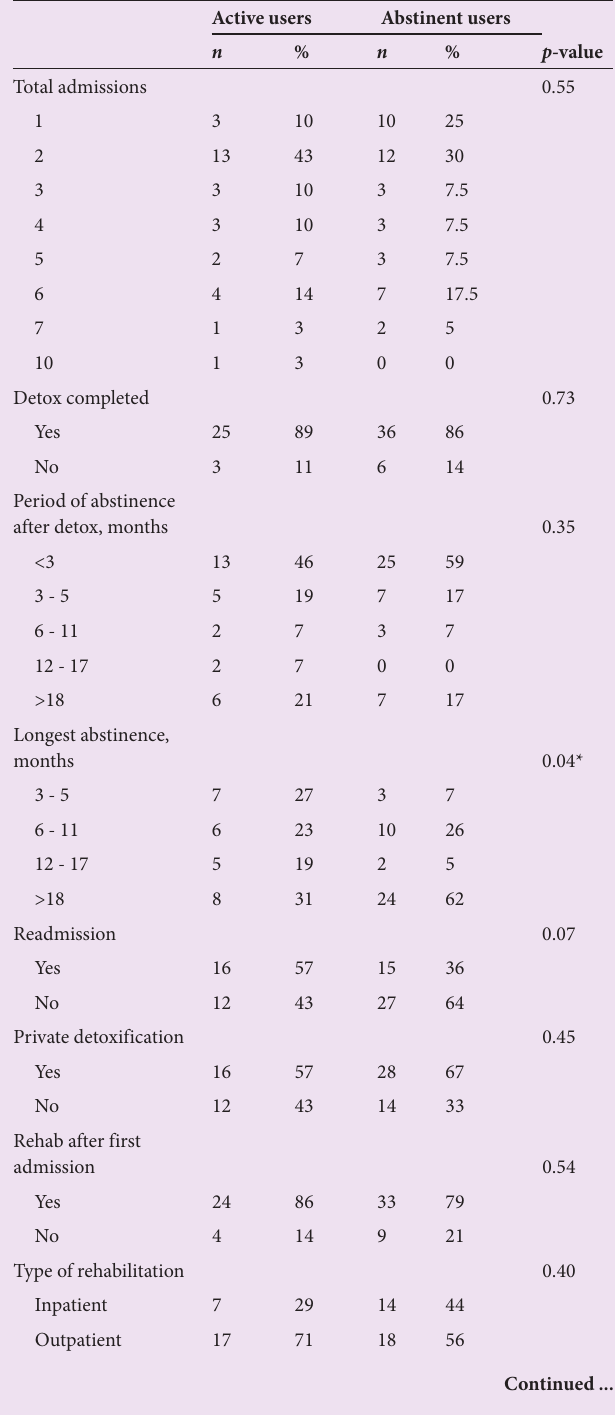
Table 4. Treatment data of active heroin users v. abstinent users during the 4 years after admission for heroin detoxification at the Opioid Detoxification Unit at Stikland Hospital (Continued